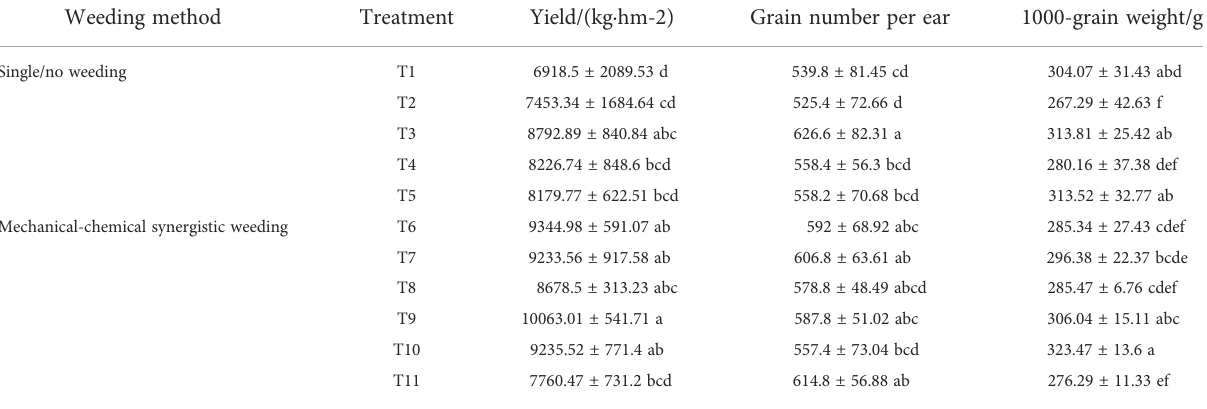
TABLE 2 Maize yield and its components under different